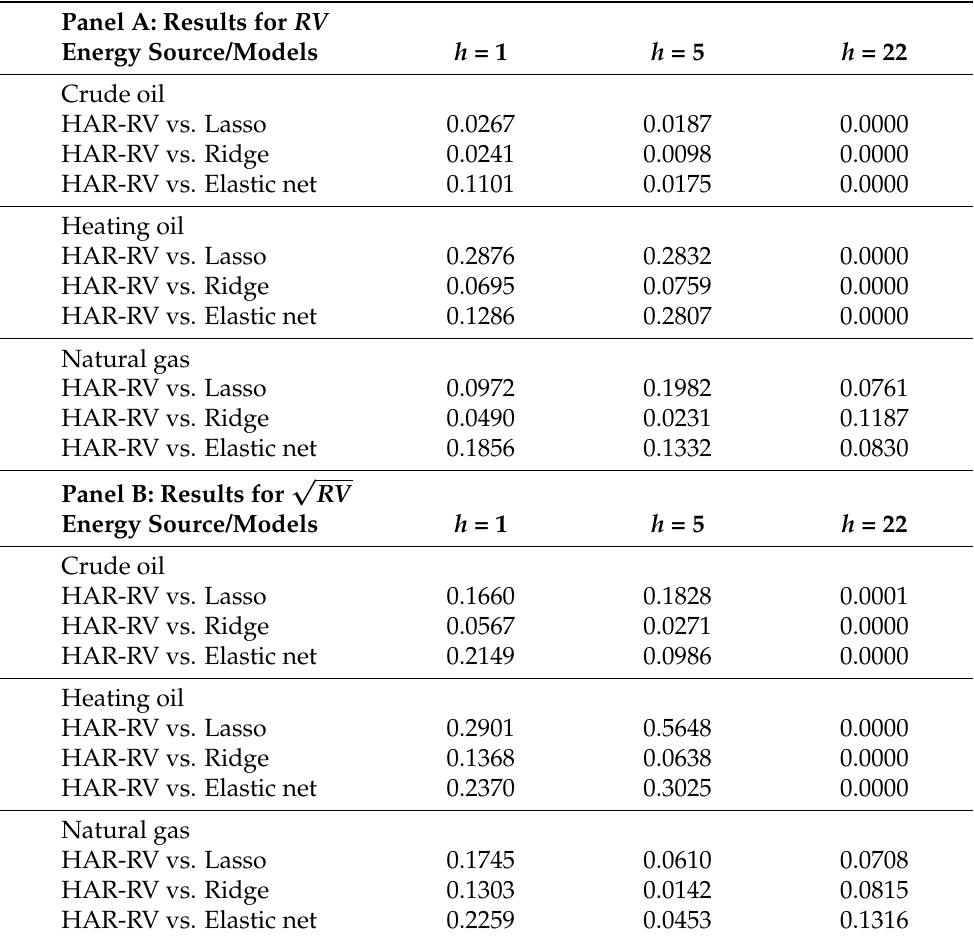
Table 5. Shrinkage results. Results ( p -values; robust heteroskedasticity and autocorrelation consistent standard errors) of the Clark–West tests for an equal mean-squared prediction error are based on robust standard errors. The classic HAR-RV model is the benchmark model, and the model extended to include all climate-risk factors and estimated by the Lasso, Ridge, and elastic-net estimator is the rival model. The alternative hypothesis is that the rival model has a smaller MSPE than the benchmark model. The parameter h denotes the forecast horizon (in days). The models are estimated using a rolling-estimation window of length 250